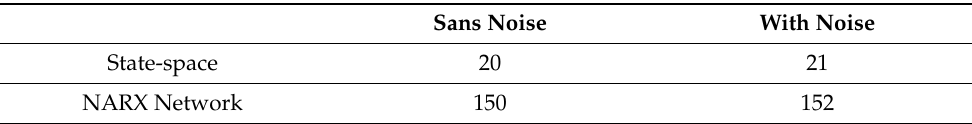
Table 6. Mean computation times, in seconds, for MPC